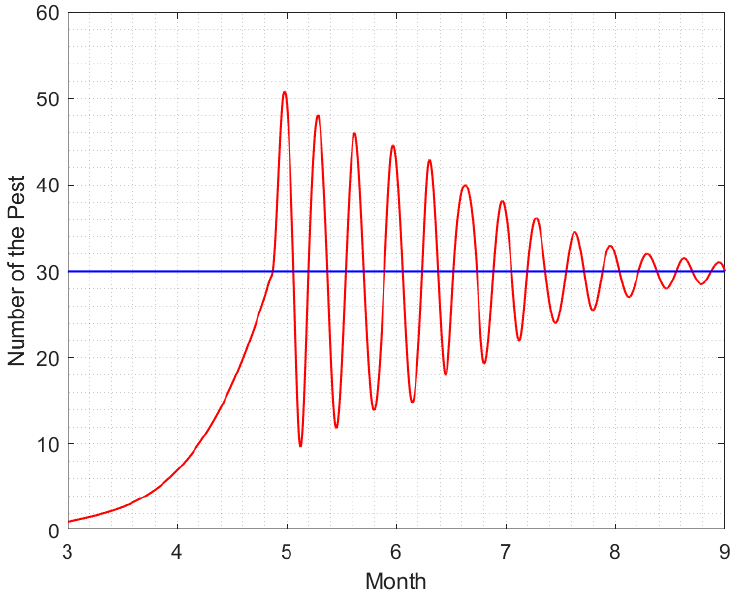
Figure 8. The results of the improved logistic model. Note: The blue line is a threshold line indicating that the population size of hornets fluctuates around the threshold line over time.